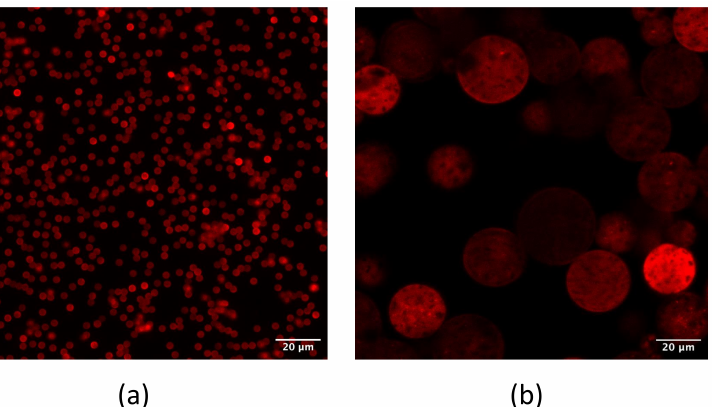
Figure 9. Characterization of the binding of a fluorescent antibody to beads (confocal analysis). Ab-A568 was conjugated either to DynaEpoxy beads coated with protein G ( a ), or to PureCubeNHS beads ( b ). Scale bars represent 20